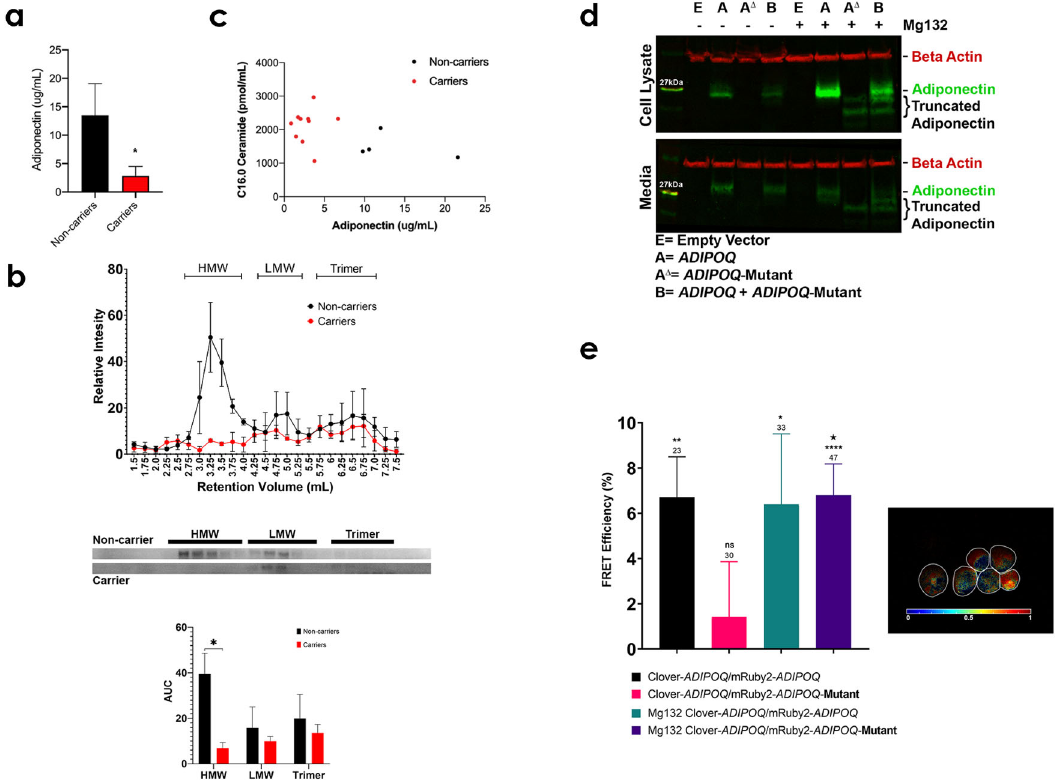
Fig. 2 Circulating adiponectin and ceramide levels and characterization of the ADIPOQ mutation. a The level of circulating adiponectin, measured by enzyme-linked immunosorbent assay (ELISA), in noncarriers (black, n = 7) and carriers (red, n = 8) of the ADIPOQ mutation